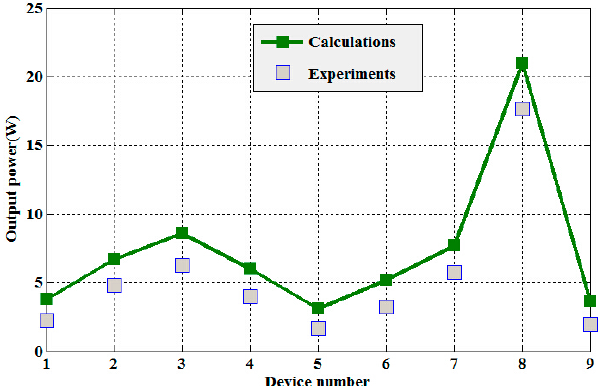
Figure 11. Calculations and experiments of output power under different energy harvesting devices.